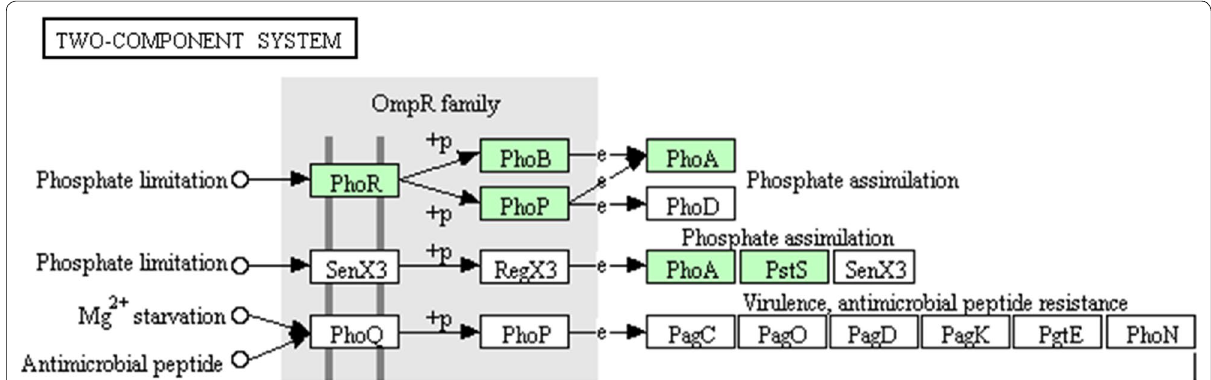
Fig. 4 KEGG pathway of genes PhoR and PhoA of Burkholderia multivorans WS‑FJ9 (Two‑component